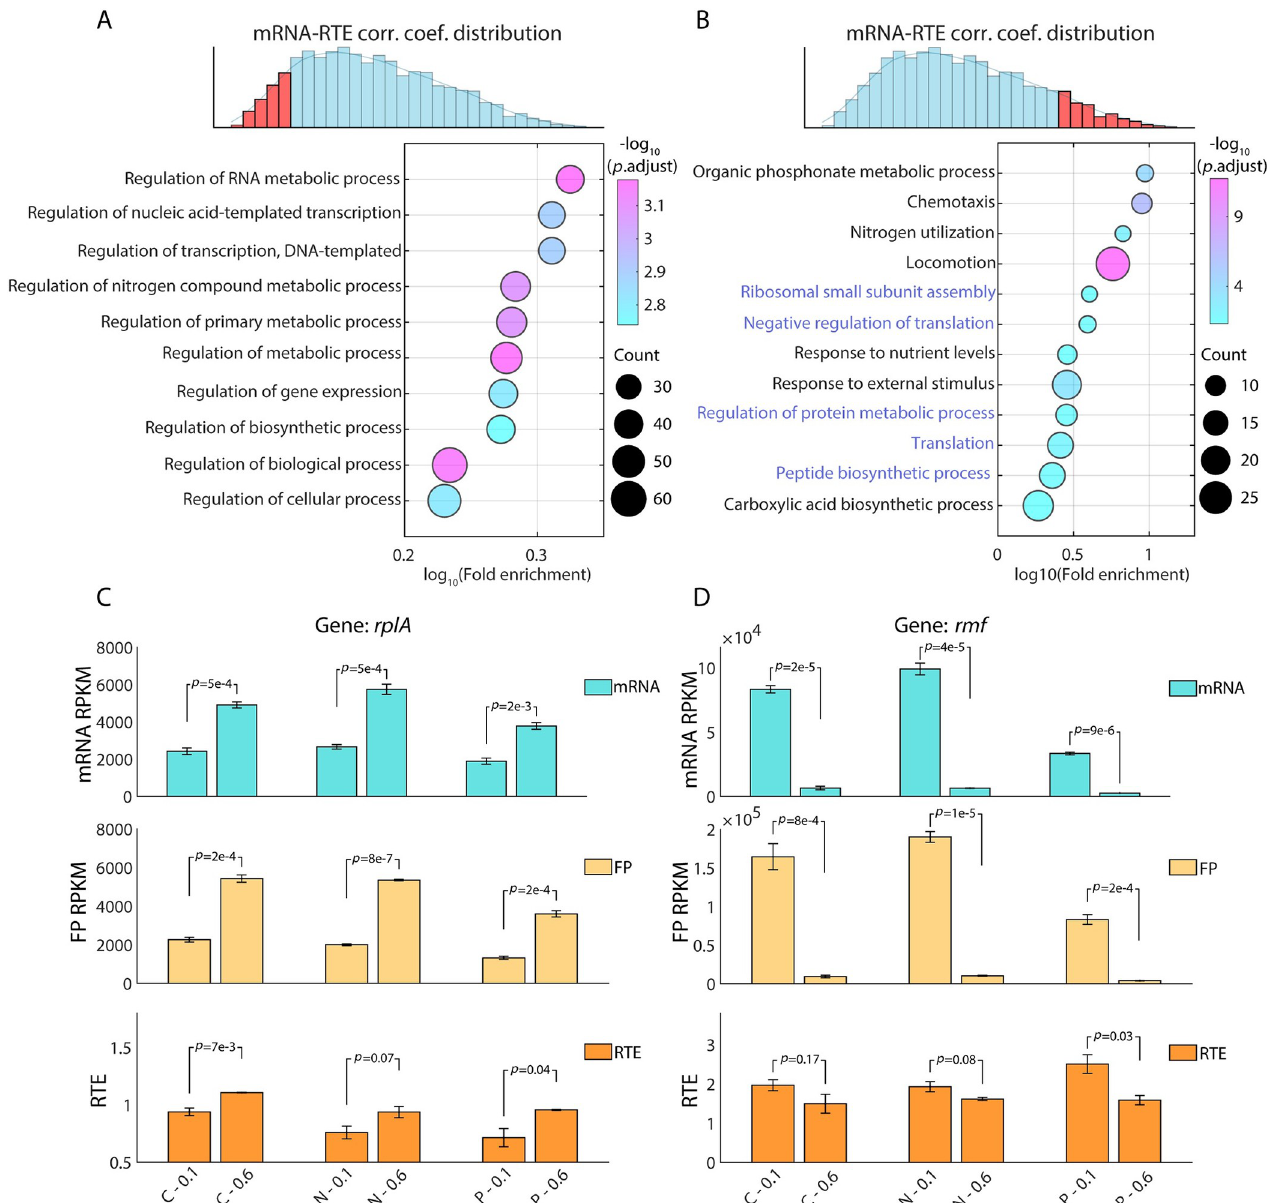
Fig 3. The correlation between mRNA level and RTE is related to specific gene functions. (A-B) Gene ontology (GO) enrichment for the top 300 genes with the most negative correlation (A) and the most positive correlation (B) between mRNA levels and RTEs. The color of the dots represents the -log 10 adjusted p - value, and the dot size represents the number of genes appearing in each biological process. (C-D) Genes regulating translation are themselves subject to translational regulation. Examples of positive correlation between mRNA level and RTE across different growth rates for one gene that promotes translation (C, gene rplA ) and one that inhibits translation (D, gene rmf ). The mRNA level (up panel), ribosome footprints (middle panel), and RTE (down panel) under 12 conditions were shown. Student’s t -test was used to calculate the p -value. Reads Per Kilobase Million (RPKM) is used for mRNA level and ribosome